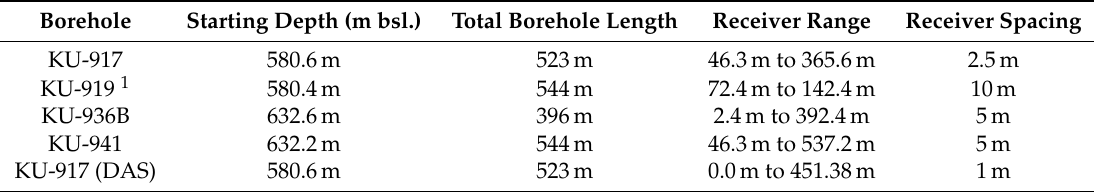
Table 1. Borehole receiver configurations for the Kylylahti Vertical Seismic Profiling (VSP) survey. The receiver range is given in downhole depth. KU-917 (DAS) refers to the the Distributed Acoustic Sensing (DAS) fiber-optic system. All other configurations used conventional three-component geophones. Borehole Starting Depth (m bsl.) Total Borehole Length Receiver Range Receiver